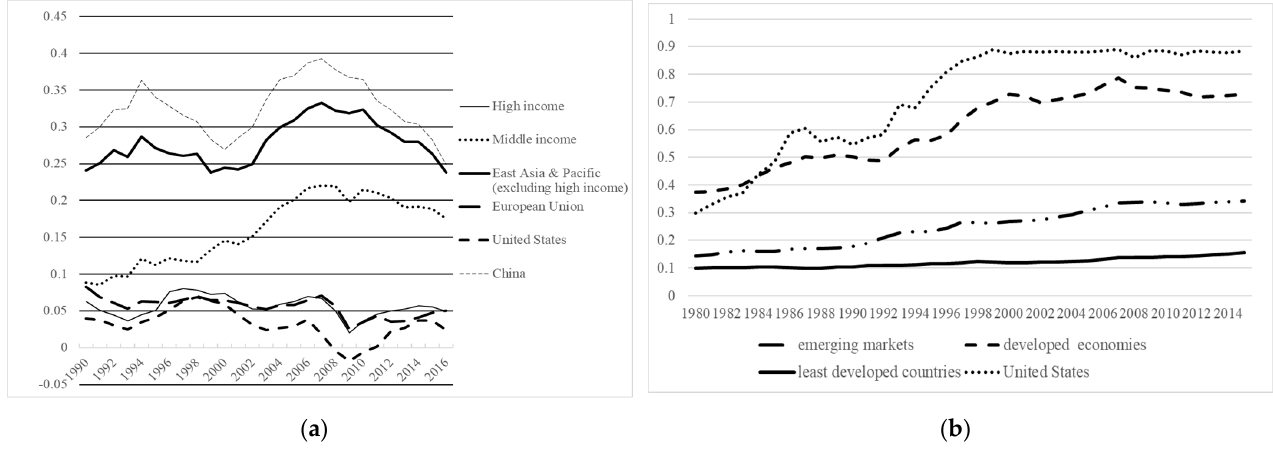
Figure 1. ( a ) Net National Savings (% of gross national income, GNI), sourced by World Development Indicators (WDI); ( b ) Financial Development Index, data from Svirydzenka [8].